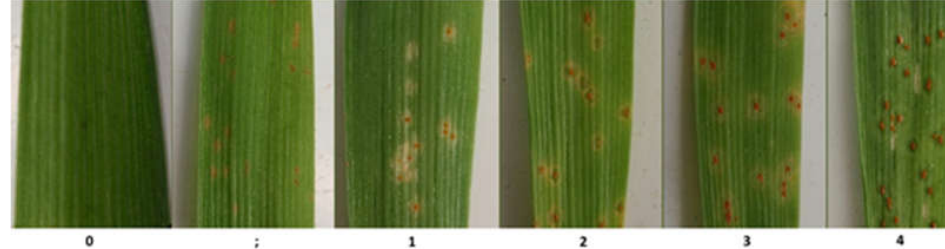
Figure 5. Range of seedling infection types for the Puccinia hordei – Hordeum vulgare interaction. The infection types were as follows: ( 0 ) = no visible symptoms; ( ; ) = hypersensitive flecks; ( 1 ) = minute uredinia surrounded by mainly necrotic tissue; ( 2 ) = small to medium sized uredinia surrounded by chlorotic and/or necrotic tissue; ( 3 ) = medium to large uredinia with or without surrounding chlorosis; ( 4 ) = large uredinia without chlorosis. Infection types of 3+ or higher were considered to be compatible (i.e., virulent pathogen/susceptible host) [33,34] .